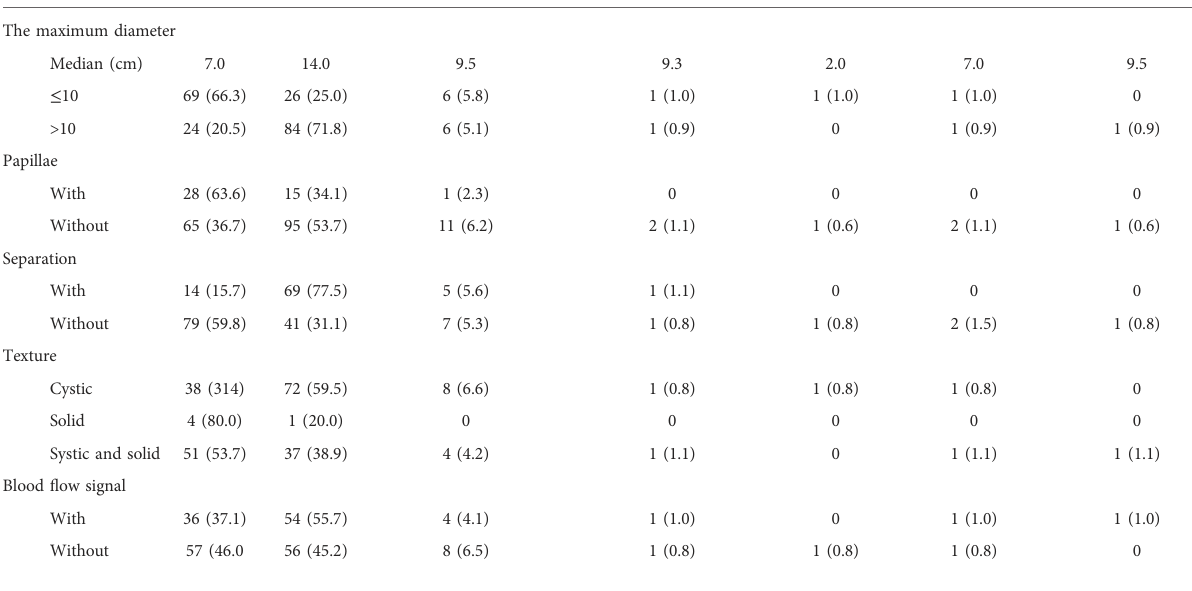
TABLE 2 The ultrasound sonogram features in 221 patients with borderline ovarian tumors.